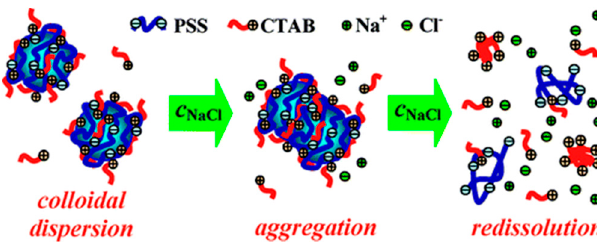
Figure 12. Schematic of effect of salt increase on polyelectrolyte and surfactant association in excess surfactant regime where colloid is charge-stabilized. The blue represents hydrophobic cores.